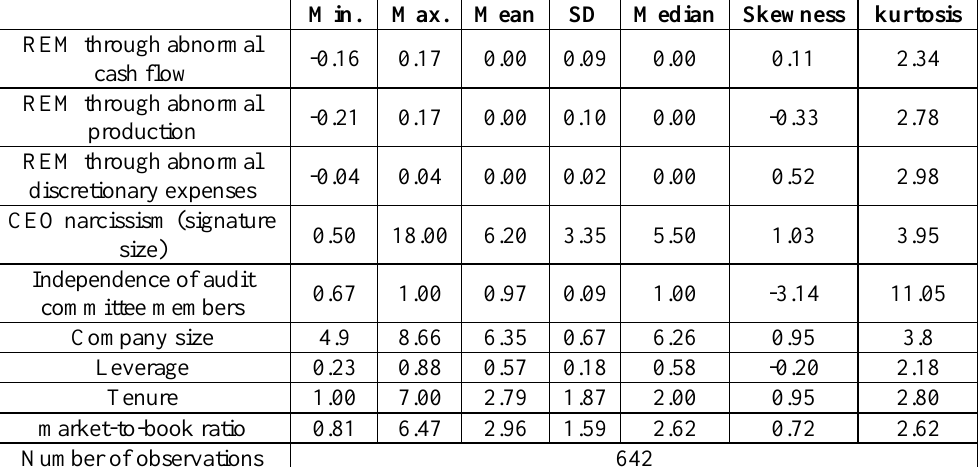
Table 1. Descriptive statistics for study